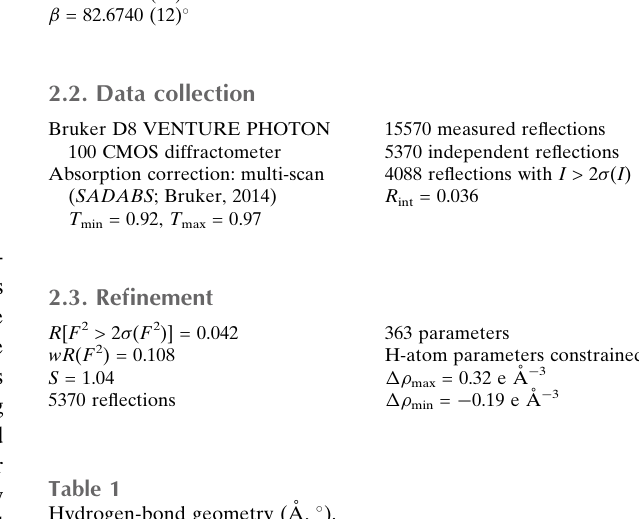
Hydrogen-bond geometry (A˚ , (cid:2)